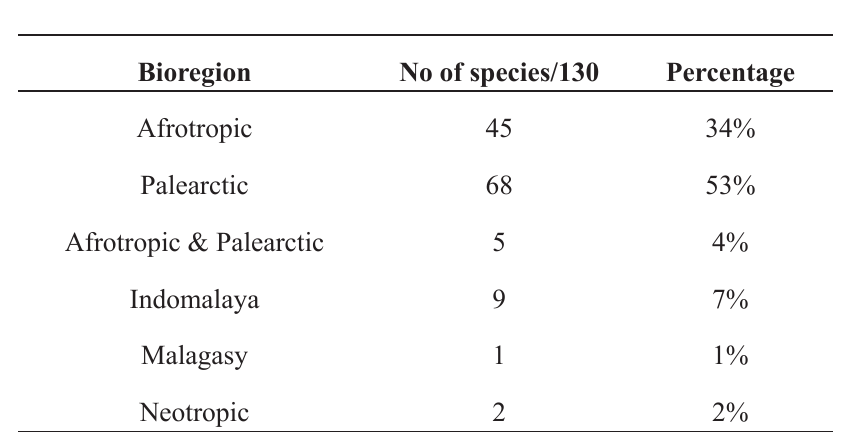
Table 2. Faunal analysis of